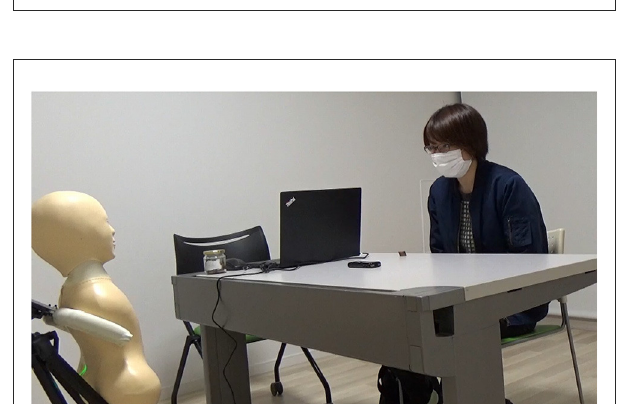
FIGURE3 Experimental setup. The participant sits facing the Telenoid, separated only by a table.